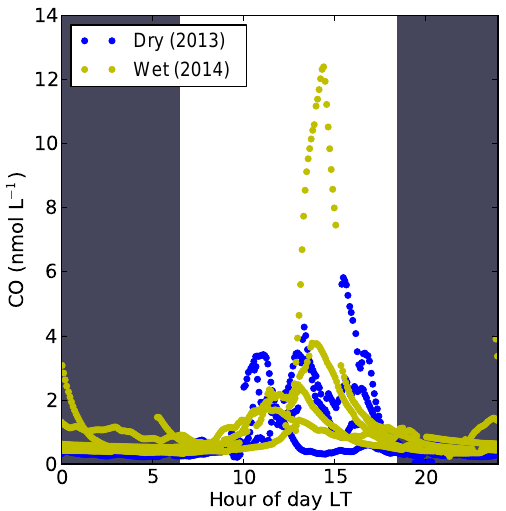
Figure 7. CO concentrations depending on the hour of the day local time. The black areas refer to nighttime hours, while the light area denotes the daylight hours. All data are gathered in this figure; 2013 and 2014 data are distinguished with different colors and symbols. Note that the boat was usually moving during daytime and more often not moving during